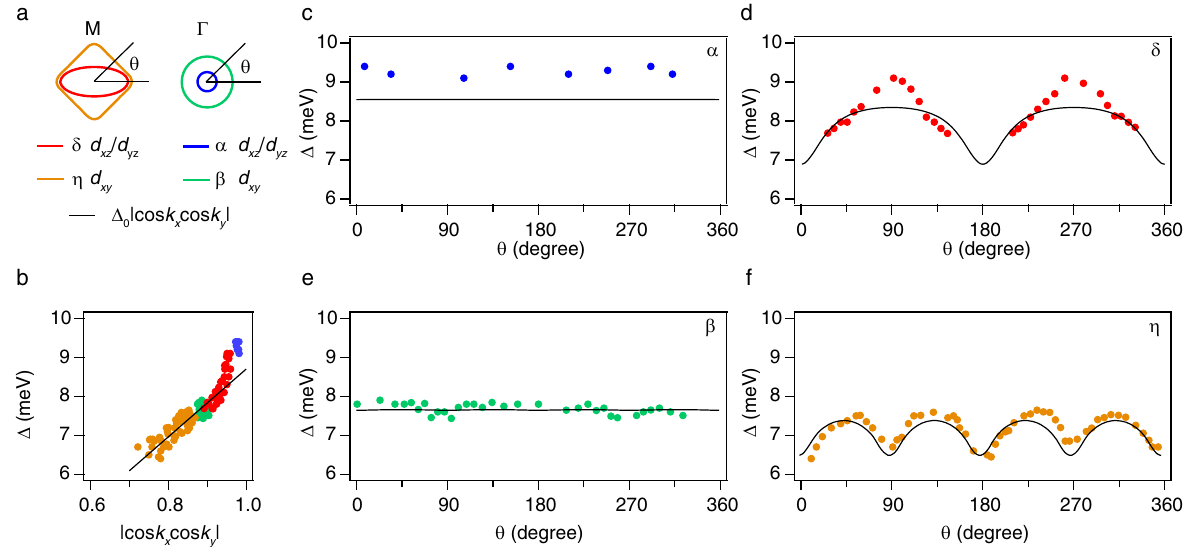
Fig. 4 Superconducting gap fi tting using an s ± gap function. a Schematic drawing of the Fermi surface of BaFe 2 (As 0.7 P 0.3 ) 2 . The orbital characters of Fermi surface are illustrated using different colors 14,17,18,39,40 . b Plot of the superconducting gap ( Δ ) as a function of |cos k x cos k y |. c Angular distribution of the superconducting gap on the α pocket. The polar angle ( θ ) is de fi ned in a . Panels d , e , and f are the same as c but taken on the δ , β , and η pockets, respectively. The black solid lines in all panels are the best fi t using the gap function Δ 0 |cos k x cos k y | with Δ 0 = 8.7